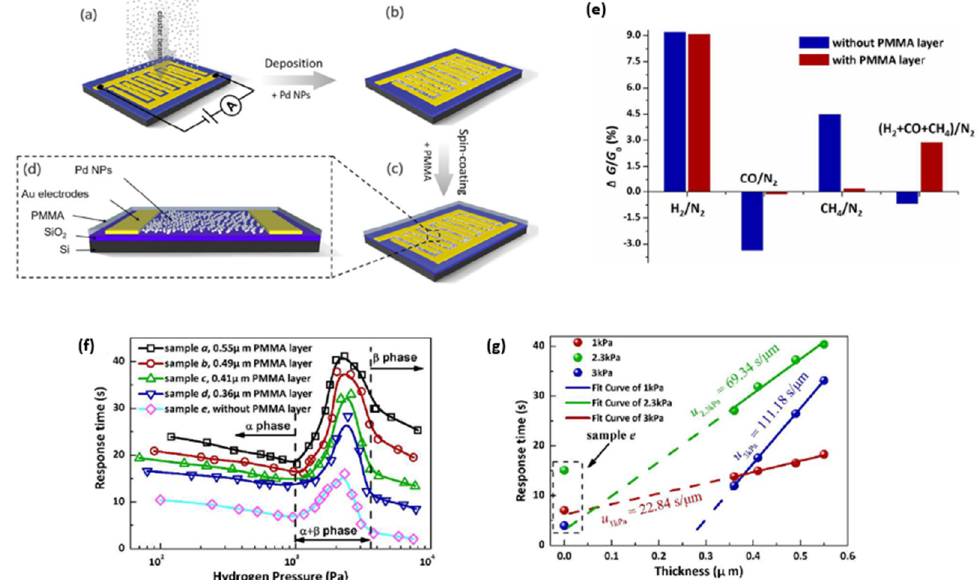
Figure 16. Schematic illustration of the procedure used to fabricate the hydrogen sensor based on a poly (methyl methacrylate) (PMMA)-membrane-coated Pd nanoparticle (NP) film. ( a ) The deposition of Pd NPs. ( b ) The Pd NP film formed on the interdigital electrode substrate after the NP deposition. ( c ) The PMMA-membrane-coated Pd NP film fabricated by spin coating. ( d ) The structure of the hydrogen sensor based on the PMMA-membrane coated Pd NP film. ( e ) The response of sensors with and without a PMMA membrane layer to target gas mixtures. The concentration of CO/N 2 , CH 4 /N 2 and H 2 /N 2 was 1000 ppm. The tested mixed gas of H 2 , CO and CH 4 in N 2 was formed by simultaneously filling the three kinds of gas into the test chamber. ( f ) Response time as a function of hydrogen pressure for five samples of different thicknesses ( a – e ). The dashed lines indicate the boundaries of the three hydride phase regions. ( g ) Plots of the response time versus the thickness of the PMMA membrane layer [82]. Copyright (2017), with permission from American Chemical Soci- ety.